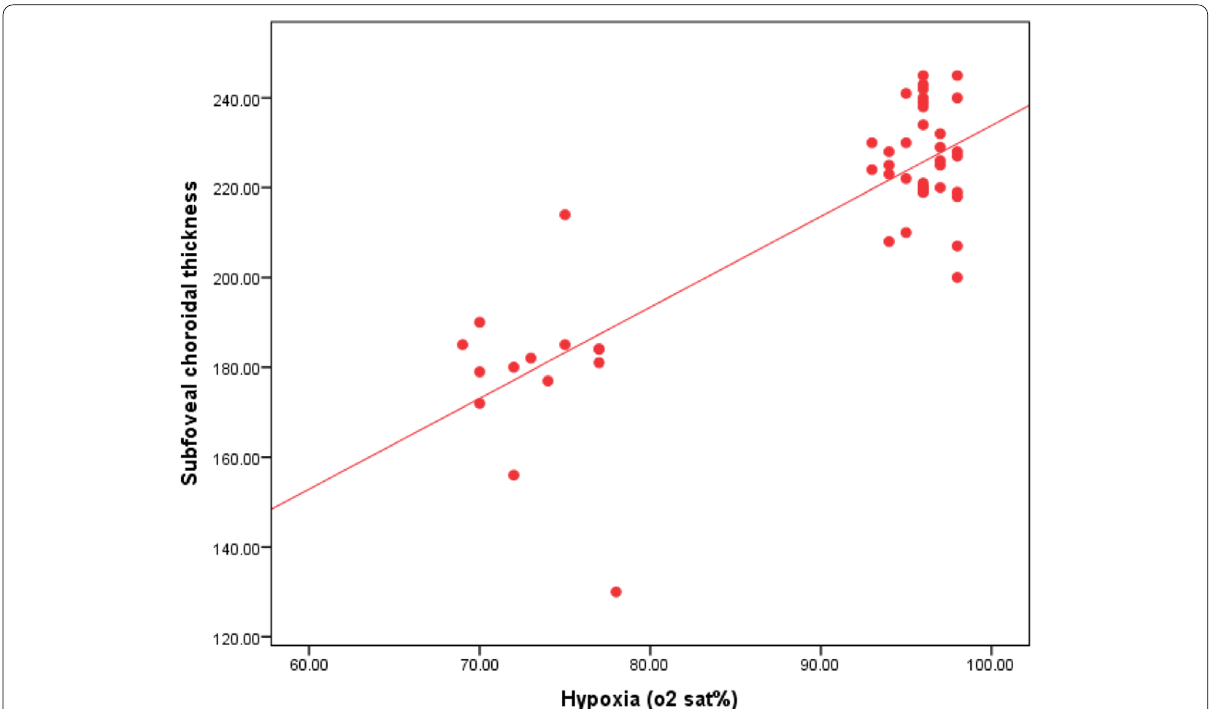
Fig. 1 Correlation between oxygen saturation of the patients and the subfoveal choroidal thickness